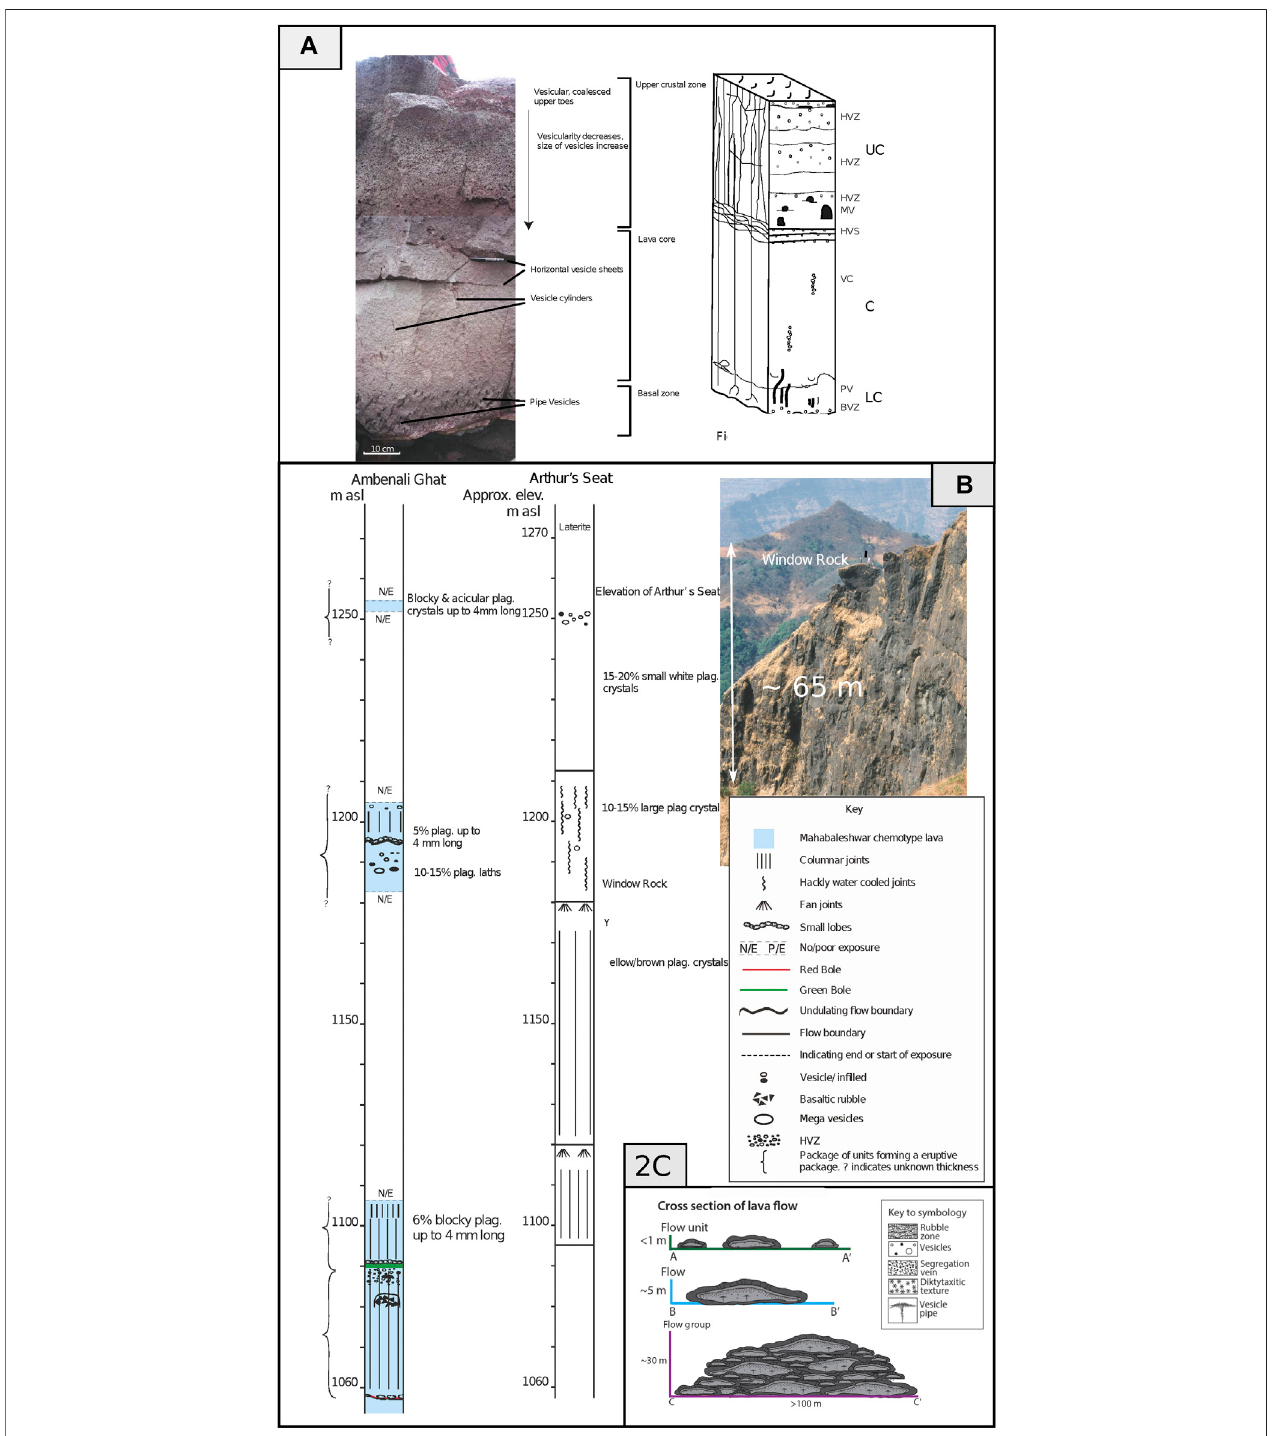
FIGURE 2 | (A) Cartoon of section through hypotheticalsheet fl owlobe, after Thordarson and Self (1998),showing common arrangement of internalphysical features; right face:UC – uppercrustalzone;C – core;LClowercrustalzone;HVZ – horizontalvesicularzone;MV – megavesicles;VC – vesiclecylinders;PV – pipevesicles;BVZ – basalvesicular zone; left face shows typical form and arrangement of cooling joints. On left, an ∼ 1 m thick lava lobe on K (cid:1) ilauea, Hawai ’ i, formed about 1991, showing all features on cartoon. (B) ComparisonoflogsofpoorlyexposedDeccanlavaswhereAmbenaliGhatclimbsthroughupperpartofMahabaleshwarFmsequencewithstratigraphicallyequivalentlavasat Arthur ’ sSeat,7 kmtonorthalongstrike,dominatedbythicksheetlobes(insetphotoshowsthe ∼ 60-m-thicklobesatWindowRock,Arthur ’ sSeat,peopleforscale!).AmbenaliGhat road area is thought to have poor exposure due to presence of thinner lobes that are more prone to erosion and weathering, representing lateral transition from thick sheet-lobe- dominated cliff exposures to N (Arthur ’ s Seat) to an area dominated by thinner lobes; modi fi ed from Jay (2005). (C) Cartoon of hummocky p (cid:1) ahoehoe pile of lava forming though stages (A – C) , based on lavas in the Kimama drill core, Snake River Plain, after Potter et al. (2019).